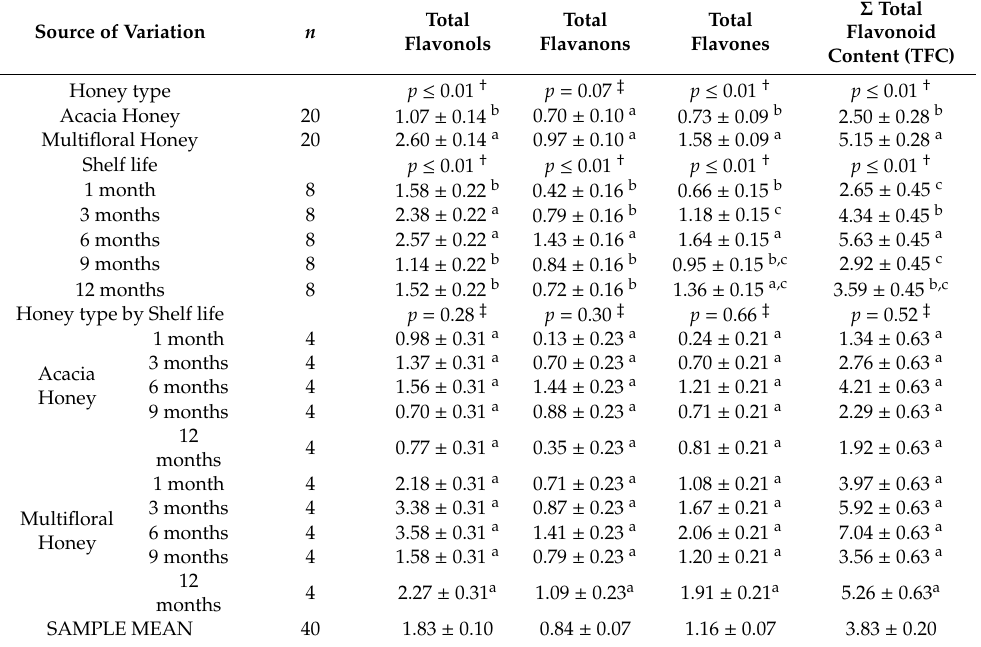
Table 1. The changes in total flavonols, flavanones, flavones and flavonoids in acacia and multifloral honey samples during 1, 3, 6, 9 and 12 months of